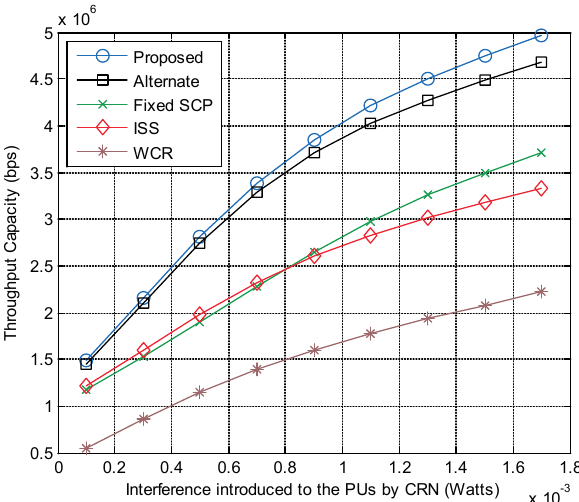
Figure 9. Throughput capacity of the CRN versus interference introduced to the PUs by several schemes with E [ | γ ( sr ) | 2 ] = 3 , E [ | γ ( ss ) | 2 ] = 3 and E [ | γ ( rs ) | 2 ] =